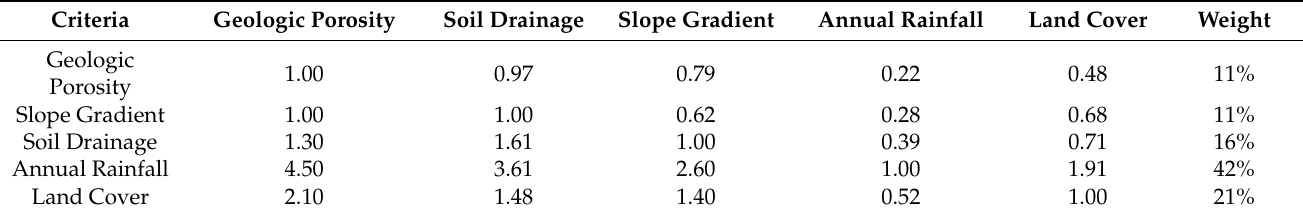
Table 3. Comparison